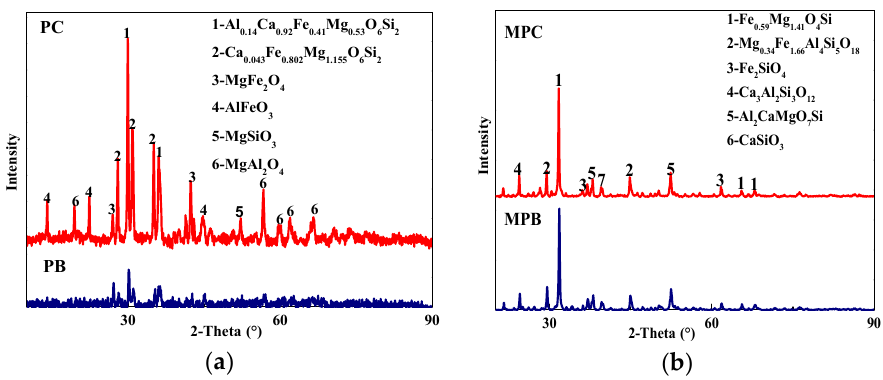
Figure 21. XRD pattern of dripping products for pellets alone and mixed burden: ( a ) pellets alone; ( b ) mixed burden.